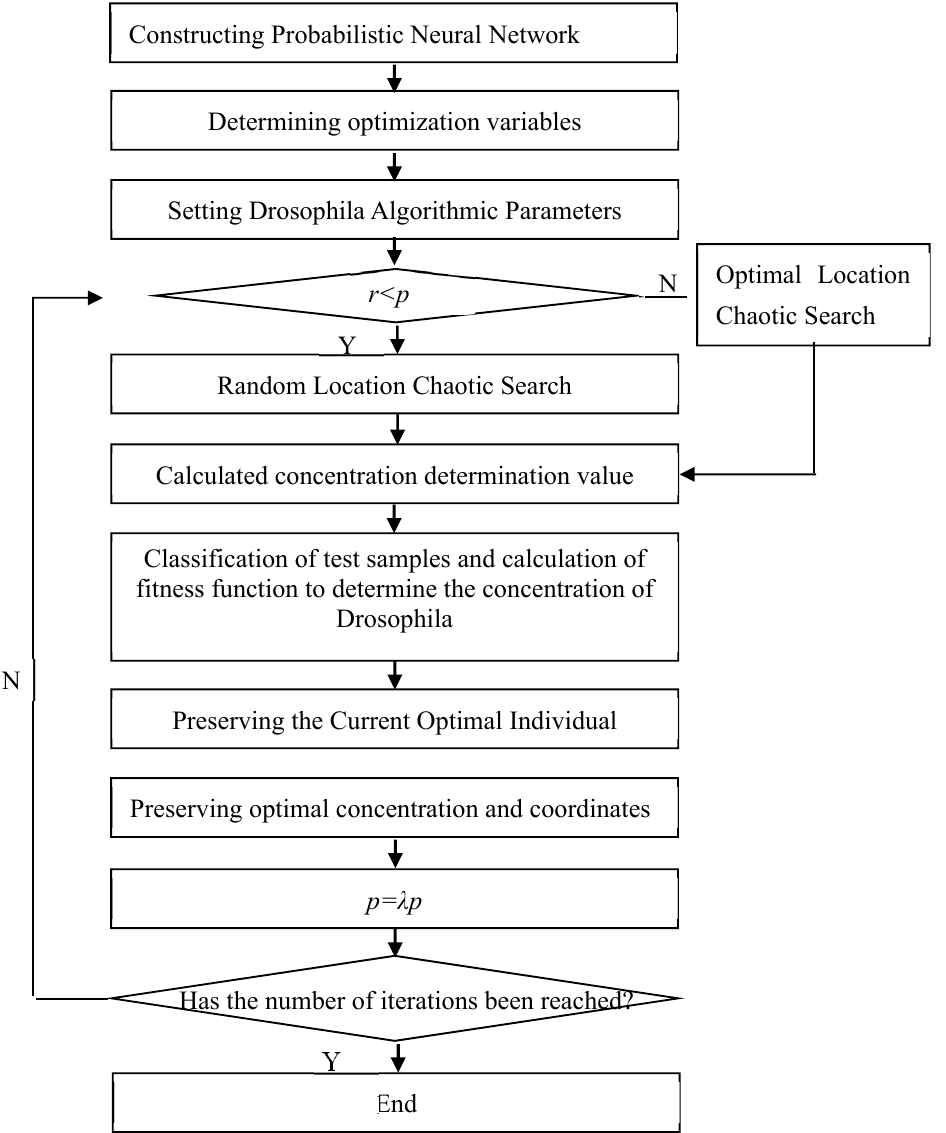
Figure 6. Optimization of probabilistic neural network based on improved fruit fly optimization algorithm.